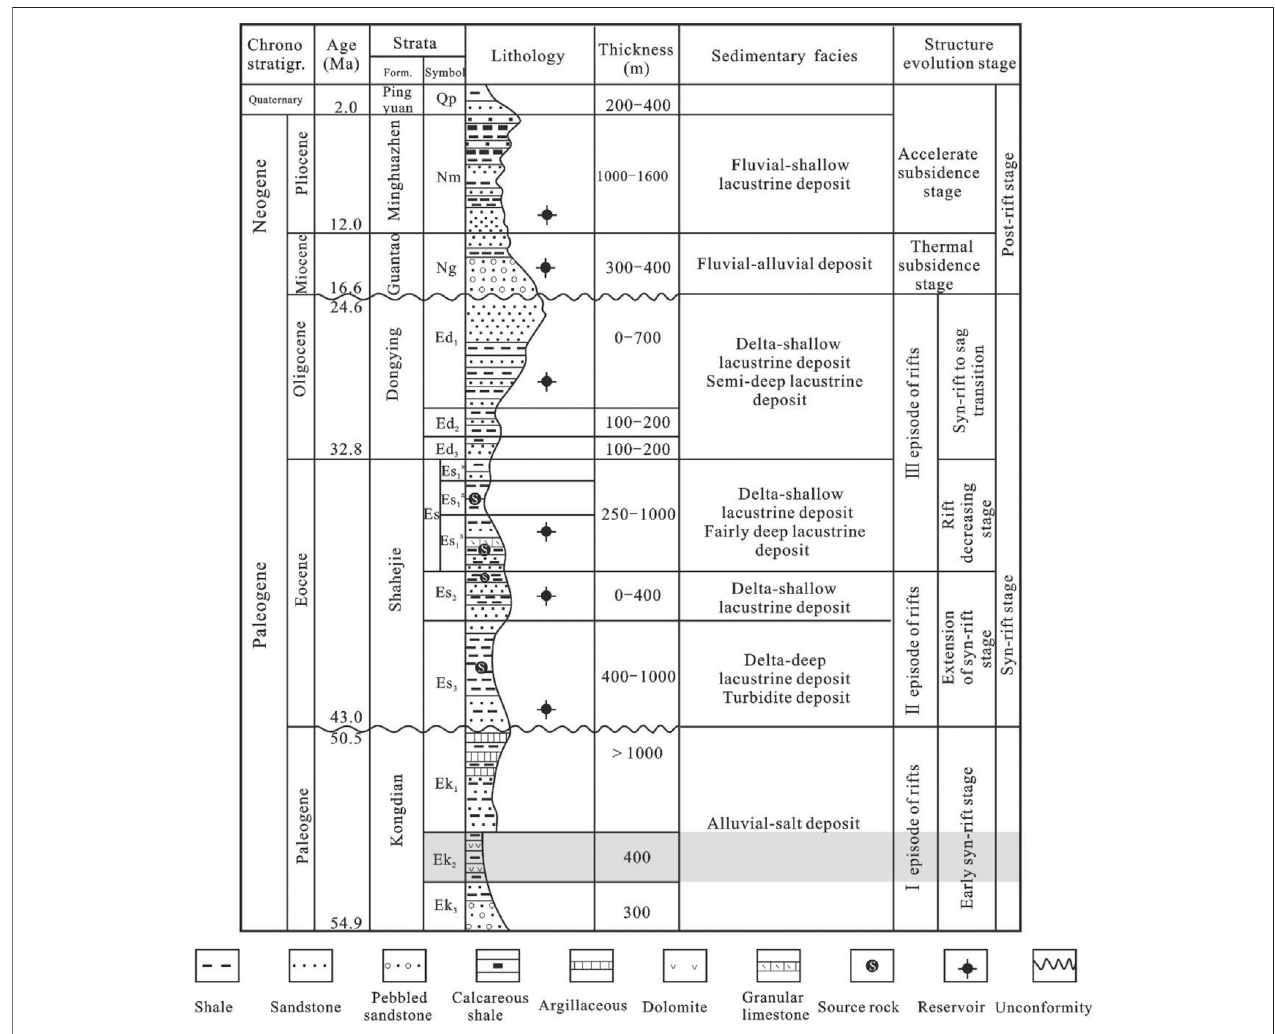
FIGURE 2 | The synthetic column of strata, sedimentary facies, possible source rocks, and reservoirs (modi fi ed after Jiang et al., 2015; Liu et al., 2017).